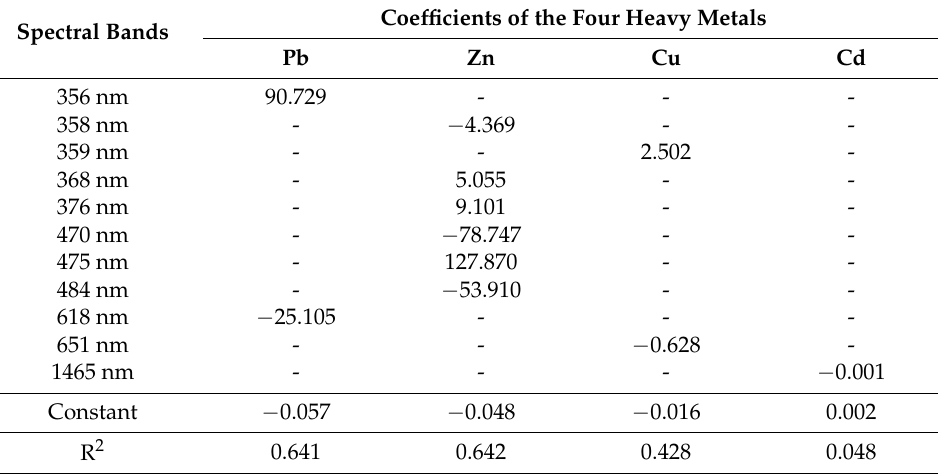
Table 3. Summary of the selected spectral bands and regression coefficients for the lab-based spectral library using stepwise multiple linear regression. A dash denotes that the spectral band was not included in the model equation for the relevant heavy